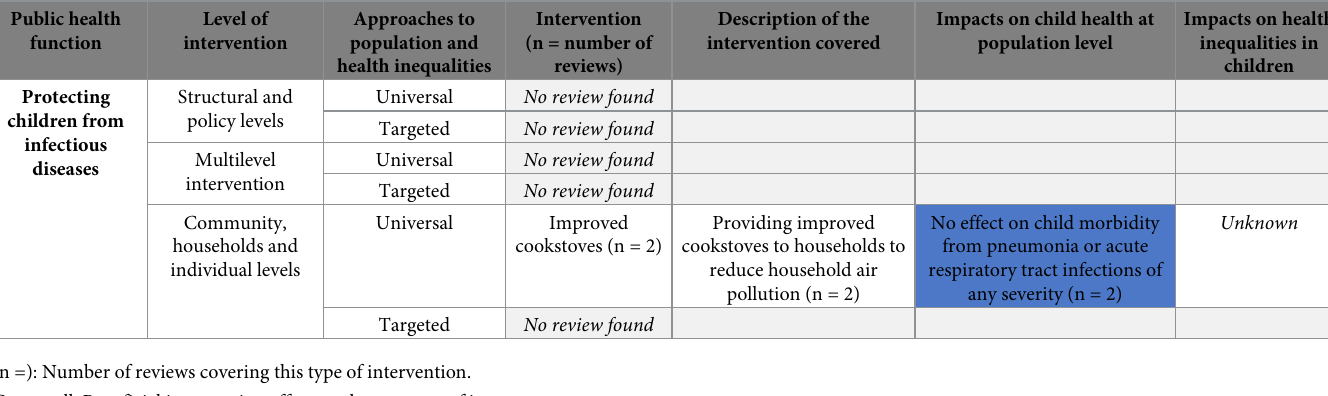
Table 4. Overview of interventions protecting children from infectious diseases covered by the reviews and their impacts on child health and health